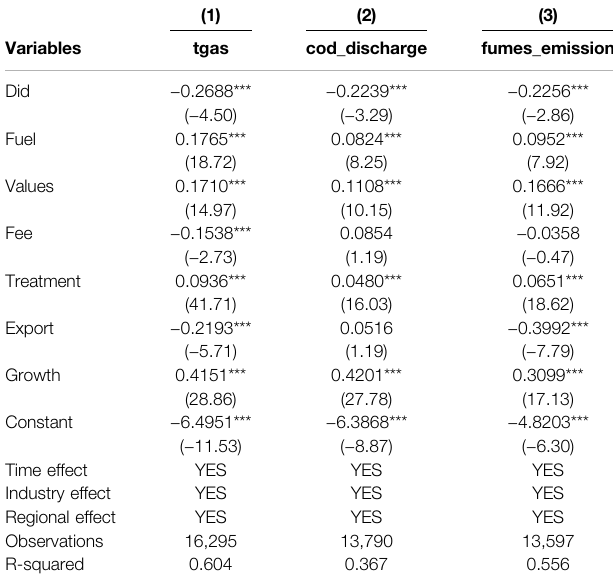
TABLE 4 | Replacing dependent